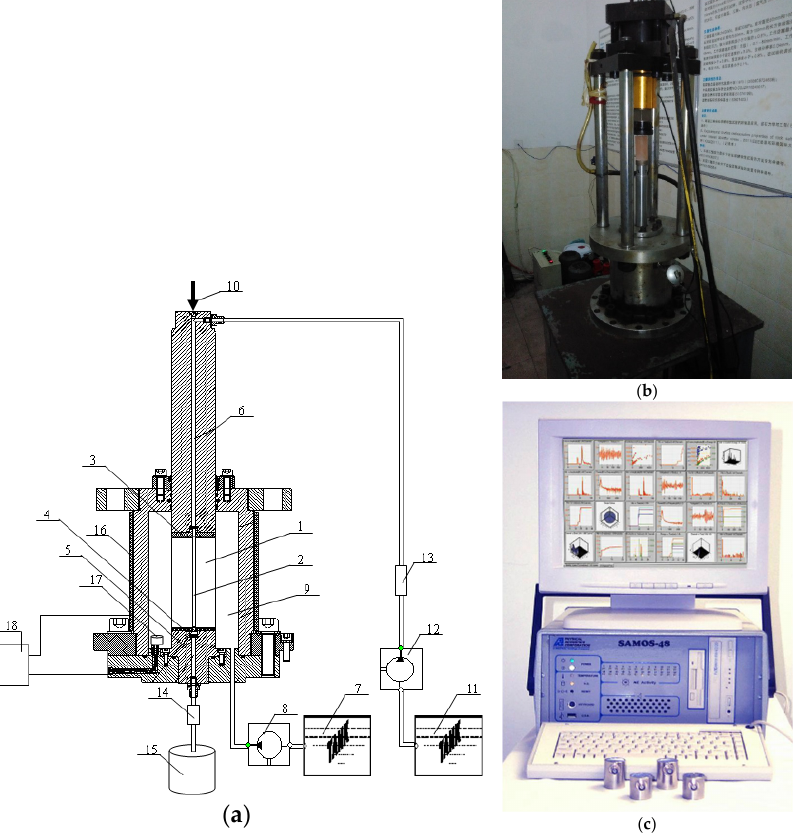
Figure 1. ( a ) The triaxial loading system.1—salt rock sample; 2—limber; 3—compression plate; 4—compression plate; 5—engine base; 6—strut; 7—cylinder; 8—servo hydraulic station; 9—confining pressure chamber; 10—axial compression; 11—dissolved liquid cylinder; 12—brine pump; 13—flow meter; 14—relief valve; 15—dissolved liquid container; 16—heat tape; 17—temperature sensor; 18—temperature controller. ( b ) The actual triaxial loading apparatus. ( c ) Acoustic emission test and analysis system.